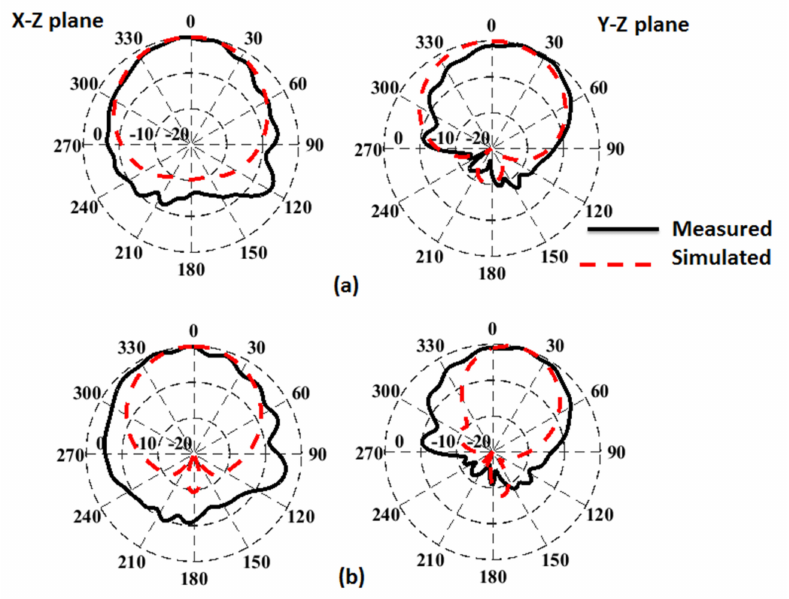
Figure 15. Normalized radiation pattern results of antenna integrated with AMC ( a ) at 2.45 GHz and ( b ) at 4.8 GHz. Table 3. The suggested design versus other published